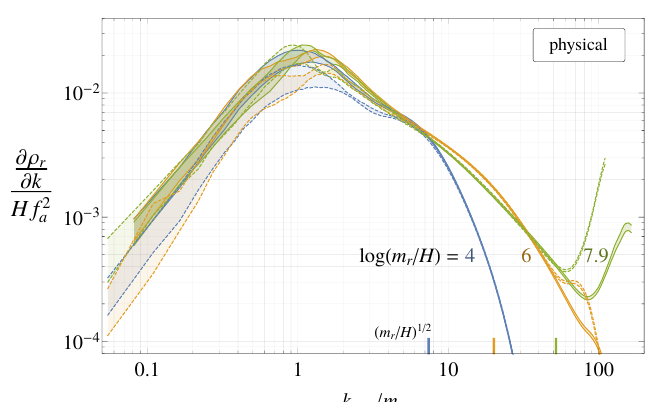
Figure 13: The energy density spectrum of radial modes for the physical string sys- tem as a function of the comoving momentum k Solid lines represent results from simulations with m ∆ = 1.5. The spectrum is dominated by an IR peak that comes from the initial m r f conditions, with modes at larger comoving momenta generated during the evolu- tion. We also indicate the comoving momentum that corresponds to m the times